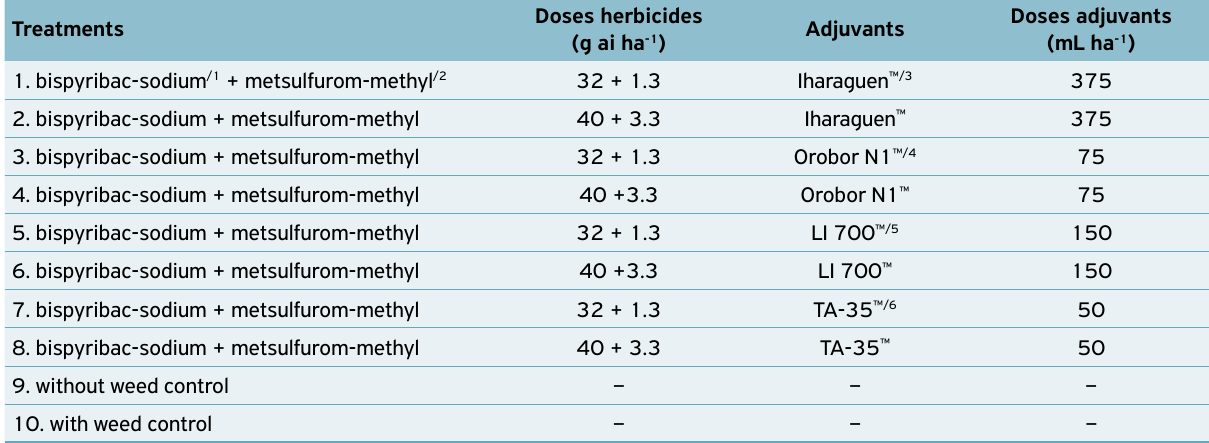
Table 1. Treatments and their dosages of herbicides and adjuvants used in irrigated rice crop control globe fringerush ( Fimbristylis miliacea ).